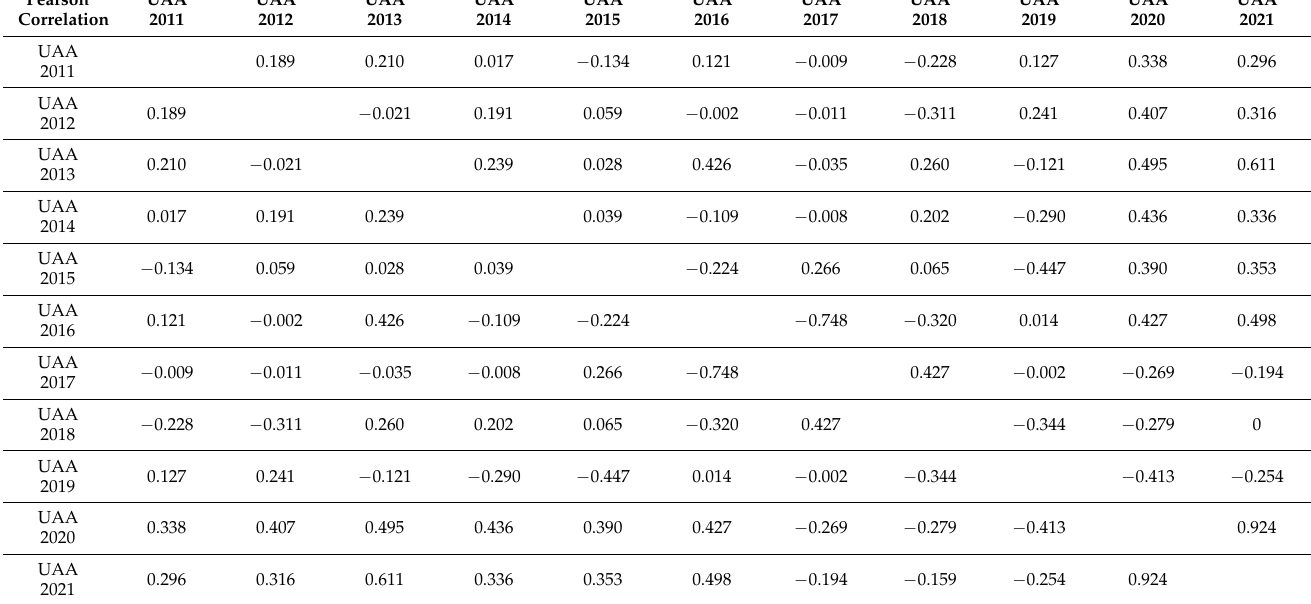
Table A6. Pearson correlation rates in dynamics for the indicator utilised agricultural area (UAA) managed by low-, medium- and high-input